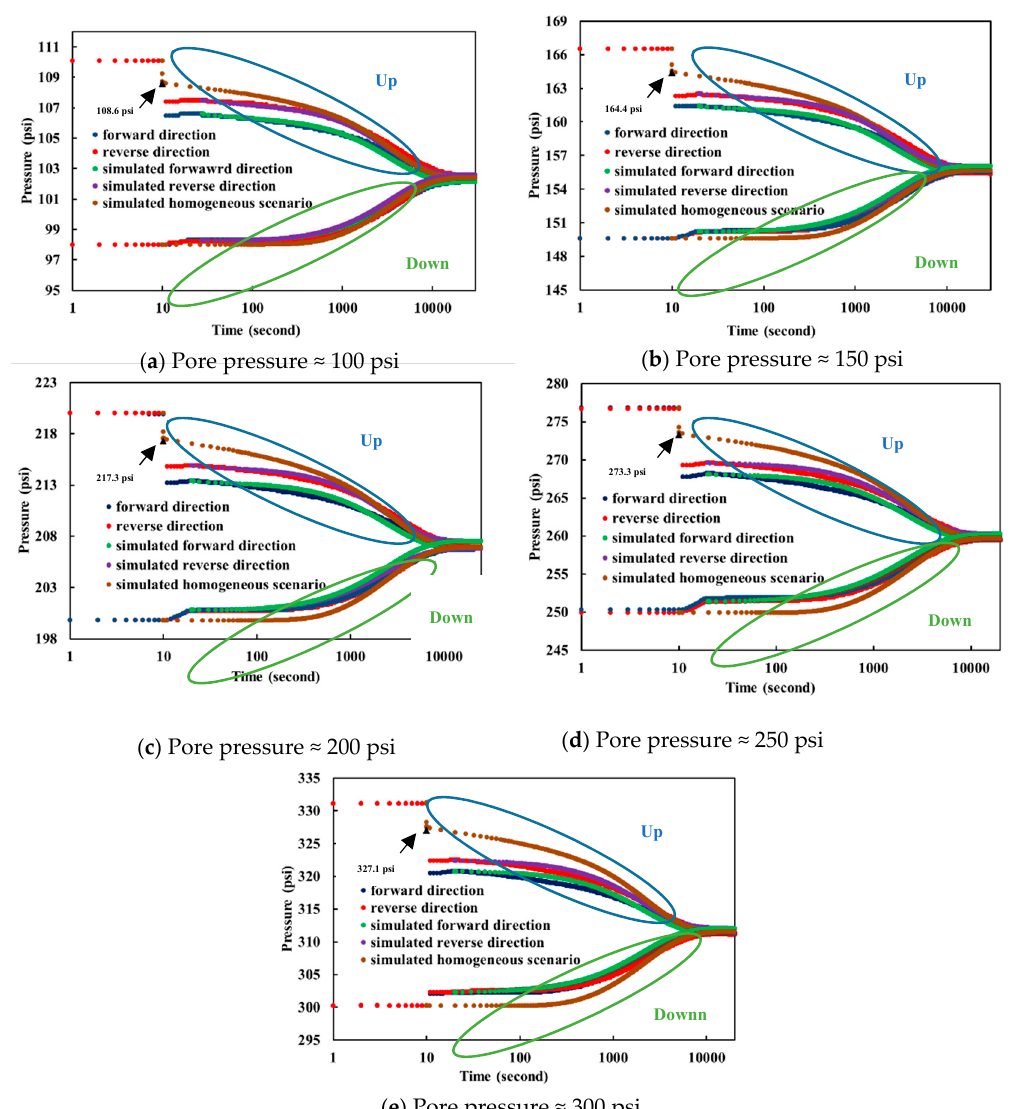
Figure 5. Experimental and simulated pressure curves in the pulse-decay experiment. Experiment results include pressure curves by flowing nitrogen in the forward and backward directions, pressure ranges from 100 psi to 300 psi (from ( a ) to ( e )). The pressure curve is adjusted within ± 0.2 psi using the same initial downstream pressure p d for better visualization of comparing pressure responses in di ff erent directions. Simulated pressure curves are generated by matching the late-time pressure response using the secondary accessible porosity, and the homogeneous scenarios are constructed based on the averaged permeability obtained from the matching results using the total porosity. The black triangle point is the reduced experimental pressure after gas freely expands from the first upstream reservoir to the second upstream reservoir if a dummy core replaces the natural core sample.